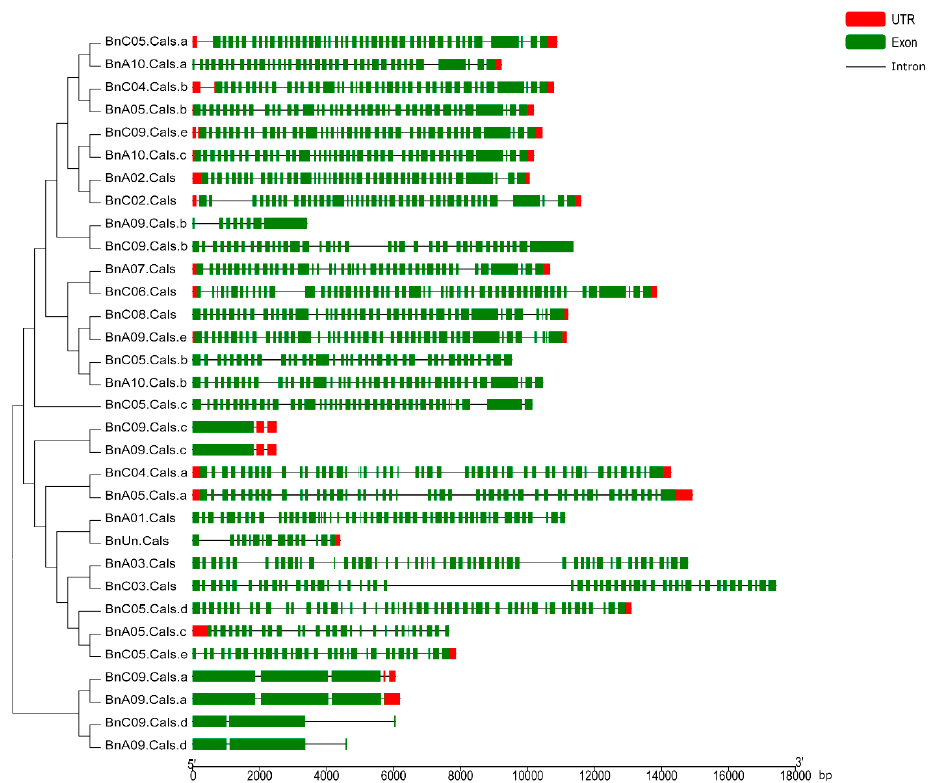
Figure 5. Gene structures of the BnCalS genes according to their phylogenetic relationships. The red boxes and green boxes indicate untranslated regions (UTR) and exons, respectively, black lines denote introns. bp: base pairs.